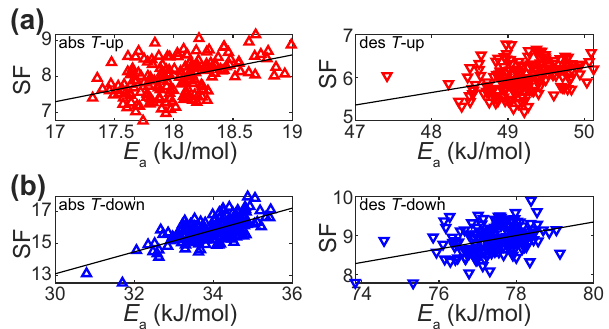
Fig. 6 Correlation of single particle kinetics slowing factor with activation energy. a Slowing factor, SF = t 50 (last) / t 50 ( fi rst) at 303 K versus activation energy, E a , obtained from the 1 st T -sweep (see Supplementary Fig. 18 for all other T -sweeps) for samples measured according to scheme T T up and b down at absorption (left) and desorption (right). For (53)/ t 50 (1) and T down SF = t 50 (43)/ t 50 (1), where numbers in parentheses indicate the cycle number at which the corresponding last and fi rst measurement at 303 K was performed for each sample. Black lines indicate linear regression to the